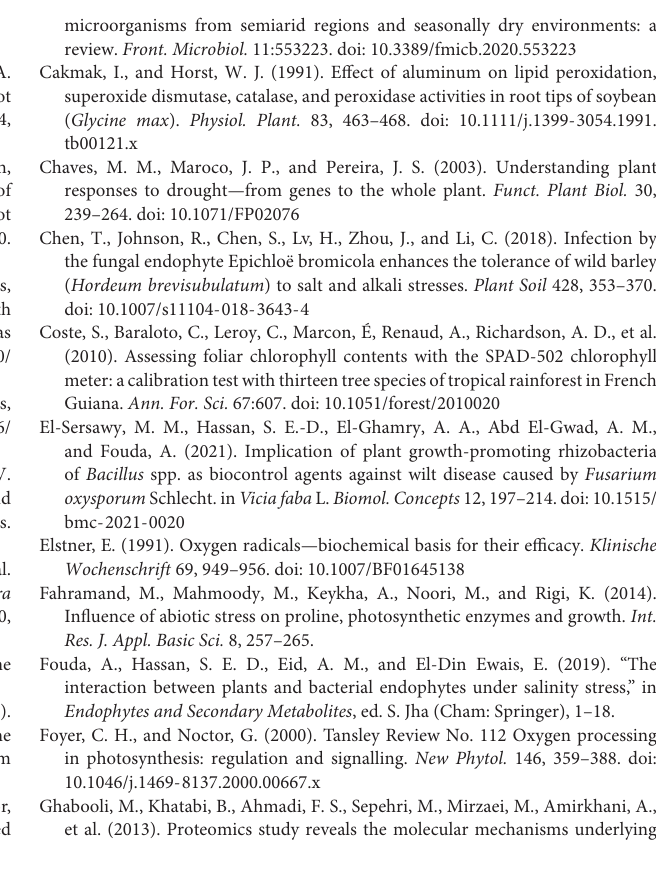
Supplementary Figure 1 | Morphological characters of three fungal endophytes reisolated from barley plants. Seven-day colonies of Neocamarosporium goegapense (A) , N. chichastianum (B) , Periconia macrospinosa (C) on Potato Detrose Agar (PDA); Conidiomata and conidia of N. goegapense (D–F) , and N. chichastianum (G,H) ; Conidiophore and conidia of P. macrospinosa (I–K)